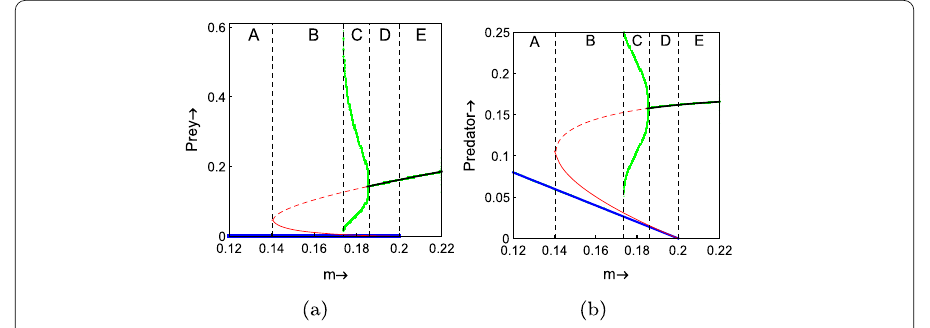
Figure 4 The bifurcation diagram by fixing k = 2.5 and varying m in (0.16,0.2). In ( a ), ( b ) the x and y components of equilibria ˆ E , E 2 , E 3 are plotted respectively, the blue line represents ˆ E and it is always stable, the red line represents E 3 and it is unstable, the red dotted line represents an unstable branch of E 2 , and the black line represents a stable branch of E 2 . The complex behavior of system (2.4a)–(2.4b) by separating critical values of m by black dotted lines into the regions namely A, B, C, D, and E. In A, ˆ E only exists and in B, C, D the ˆ E , E 2 , E 3 exist. In C, the unstable E 2 is surrounded by stable limit cycle (green curve), and when m = c = 0.2 the ˆ E , E 3 coincide with the saddle equilibrium E 0